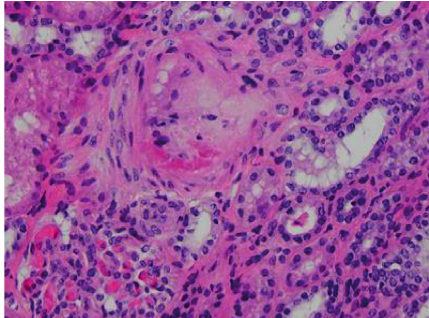
Figure 3: Intimal fibrinoid changes in interlobular artery